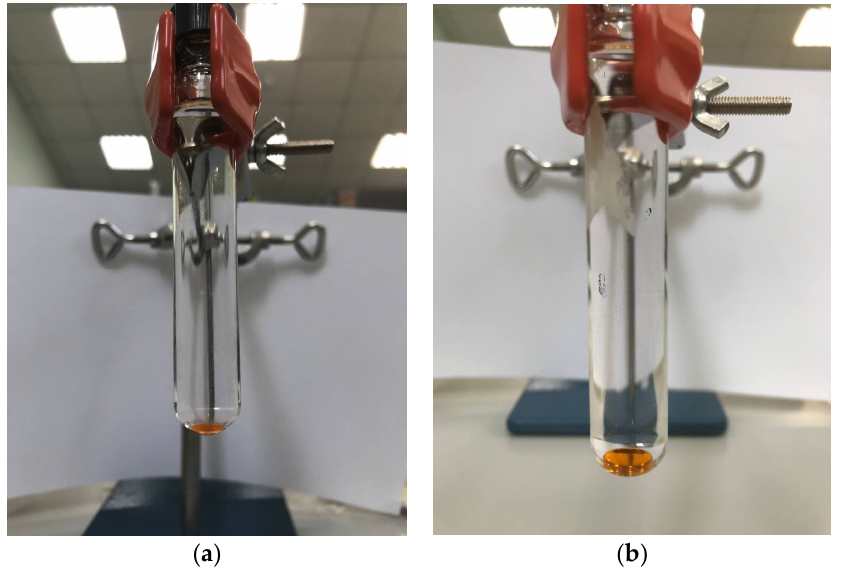
Figure 1. Comparison of polycyclic aromatic hydrocarbon (PAH) recoveries from water samples by using various extraction solvents.